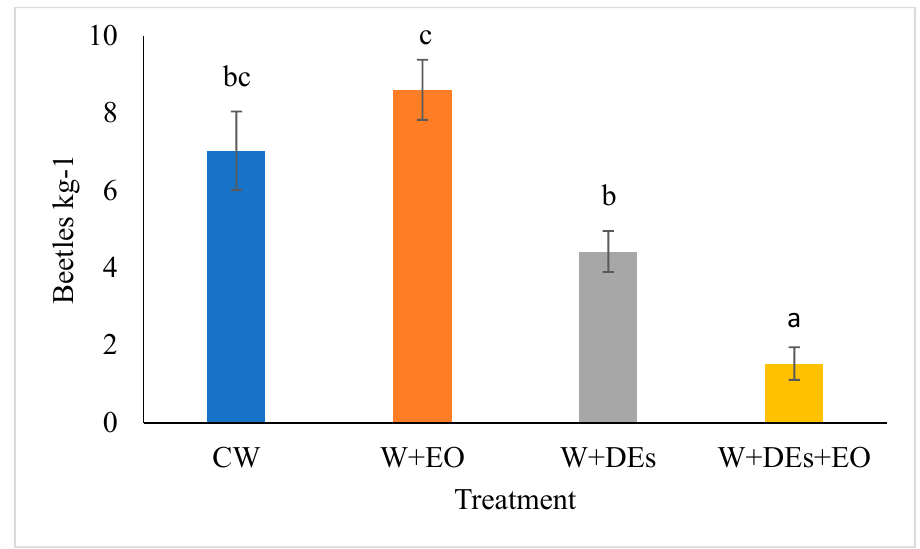
Figure 3. Average beetle infestation of the wheat stored in the mini-silos. CW, control wheat; W + EO, wheat treated with the essential oil of Ocimum basilicum ; W + DEs, wheat treated with diatomaceous earths; W + DEs + OE, wheat treated with O. basilicum essential oil and diatomaceous earths. Data represent the mean number of adults kg -1 of grain. Bars represent the standard error. Different letters indicate significant differences among the treatments according to Tukey’s b post-hoc test ( p < 0.05).